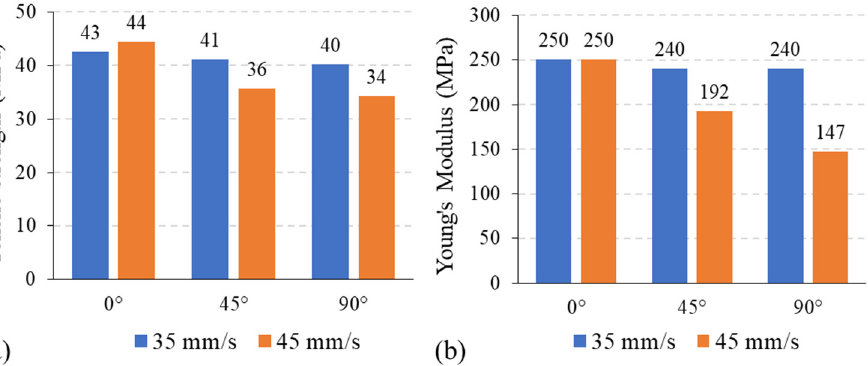
Figure 20. PETG ( a ) strength and ( b ) Young’s modulus sensitivity to printing speeds with different raster angles (in degrees).